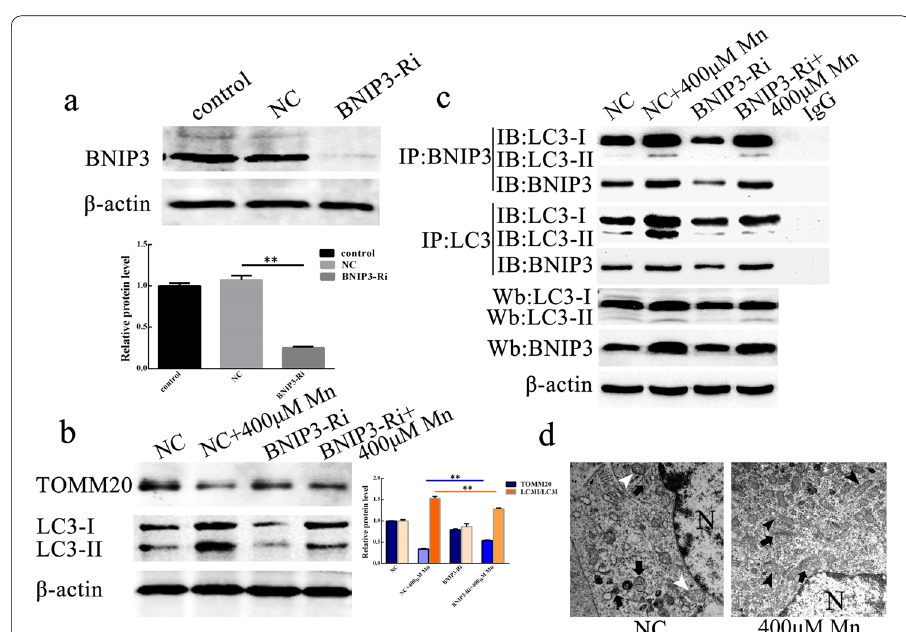
Fig. 4 BNIP3 mediated MnCl 2 -induced mitophagy. a BNIP3 levels in cells transfected with or without BNIP3 shRNA lentiviral vector were verified by western blot. β-Actin as internal reference. * P < 0.05, ** P < 0.01. C, control treatment. NC, cells not transfected with lentivirus carrying interference sequences (also referred to as negative control). BNIP3-Ri, BNIP3-shRNA-transfected cells. b After treatment with 400 µM MnCl 2 , TOMM20 and LC3 protein levels were measured by western blot. β-actin served as the internal reference. Compared with NC, * P < 0.05, ** P < 0.01. NC, negative control treatment. NC Mn, 400 µM MnCl 2 treated, + not transfected with lentivirus interference sequence at 24 h. BNIP3-Ri, BNIP3-shRNA-transfected cells. BNIP3-Ri Mn, 400 µM MnCl 2 -treated, BNIP3 shRNA-transfected cells at 24 h. c Co-immunoprecipitation + result showed mitophagy receptor protein BNIP3 and autophagy marker protein LC3 bound to each other. MnCl 2 promotes their binding, whereas BNIP3 shRNA transfection weakens this mechanism mediated by MnCl 2 . NC, negative control treatment. NC Mn, cells treated with 400 µM MnCl 2 but not transfected with + lentivirus carrying interference sequences at 24 h. BNIP3-Ri, BNIP3 shRNA-transfected cells. BNIP3-Ri Mn, + 400 µM MnCl 2 -treated, BNIP3 shRNA-transfected cells at 24 h. d Mitophagy bodies and mitochondria in cells with normal or low BNIP3 expression were observed by TEM. N, nucleus. White arrow, expanded, condensed or dissolved, mitochondria aggregates. Black arrowhead ( ), relatively normal mitochondrial morphology. Black arrow ( ), mitophagy